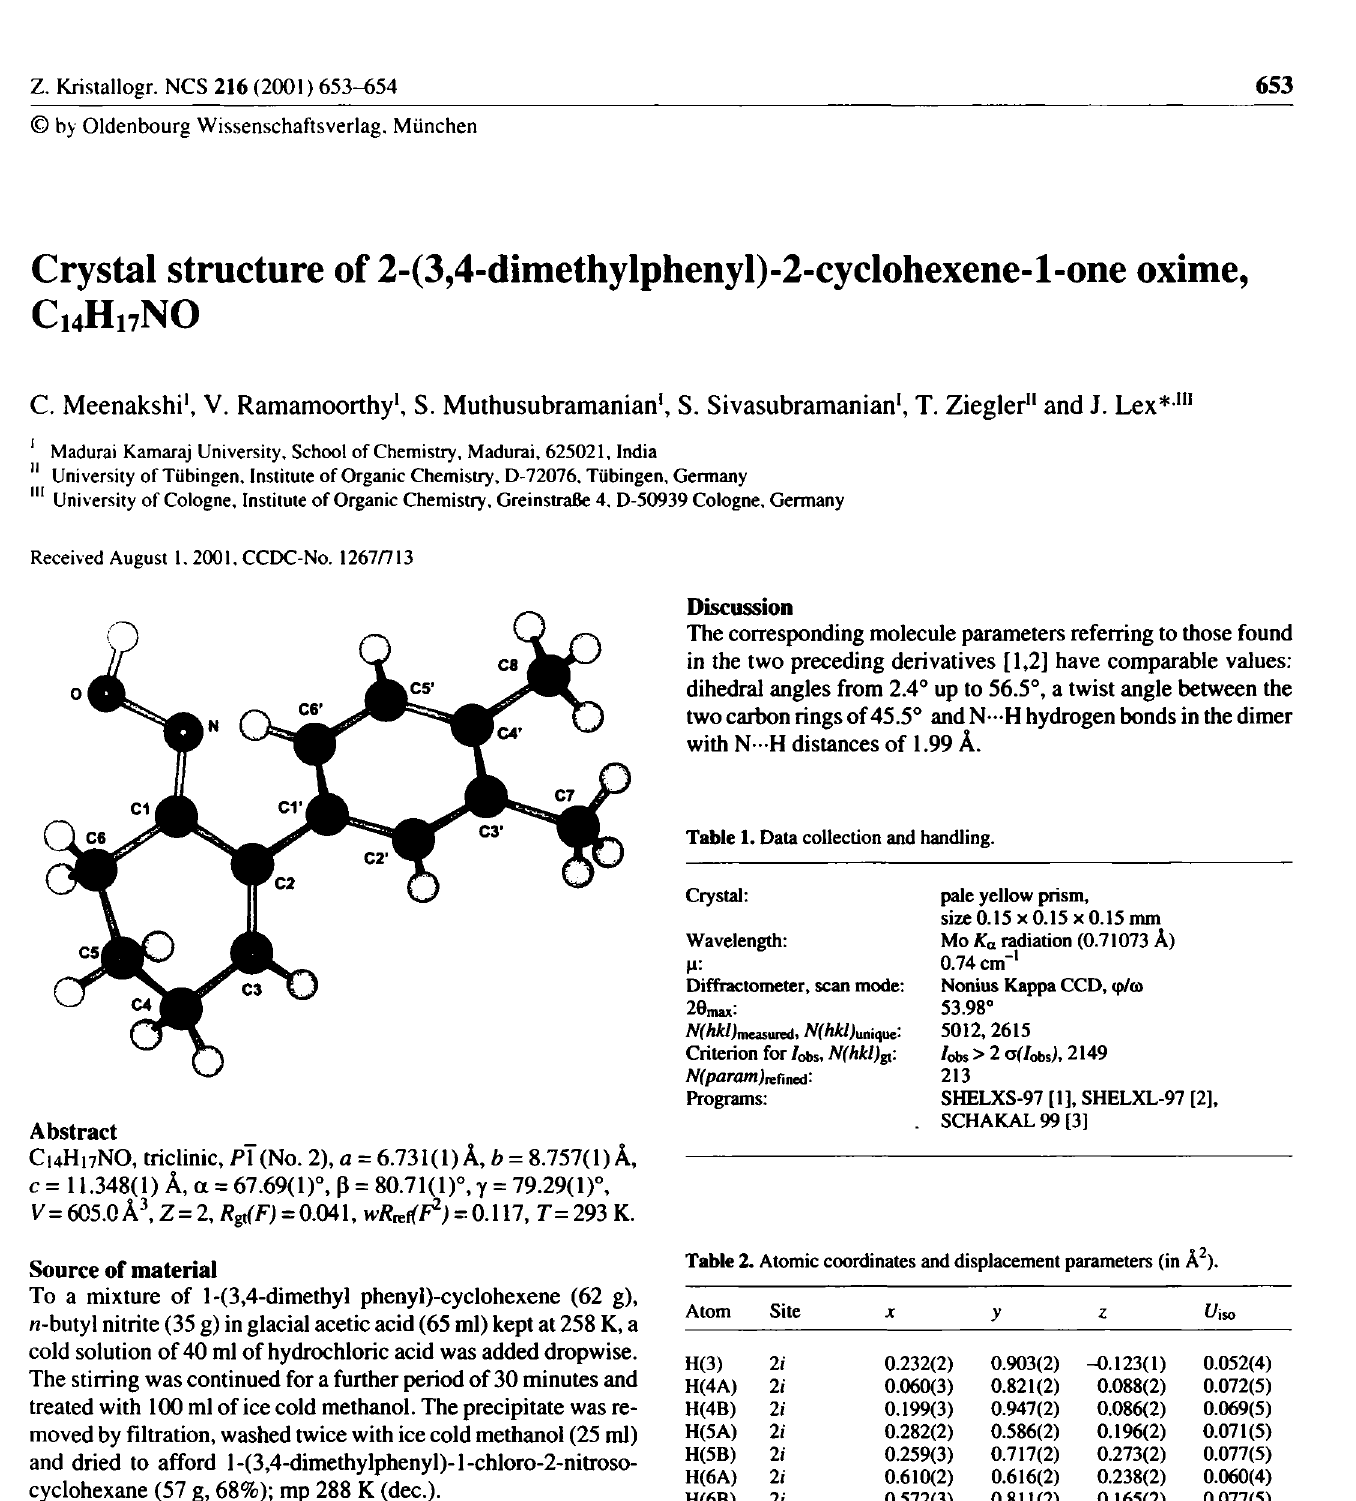
Table 2. Atomic coordinates and displacement parameters (in Ä 2